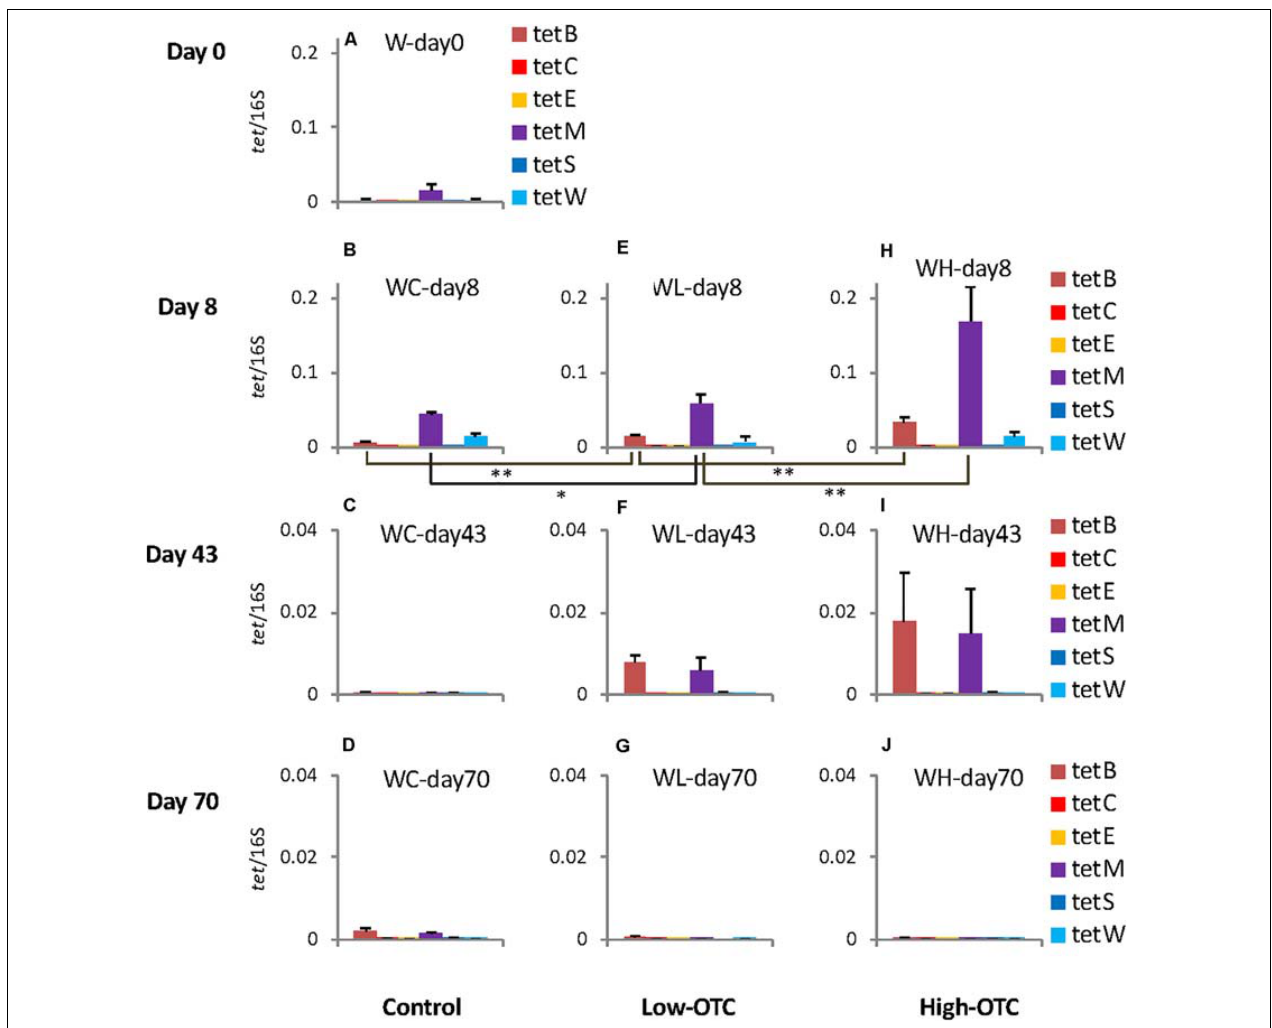
FIGURE 2 | Copy numbers of the six tet genes in rearing water in each tank; values were normalized to those of 16S rRNA genes in the respective samples. Error bars indicate the standard deviation of triplicate samples. Single asterisk, p < 0.05; double asterisk, p < 0.01. In (A–J) sample codes are: W, water; C, control; L, Low-OTC; H, High-OTC; and